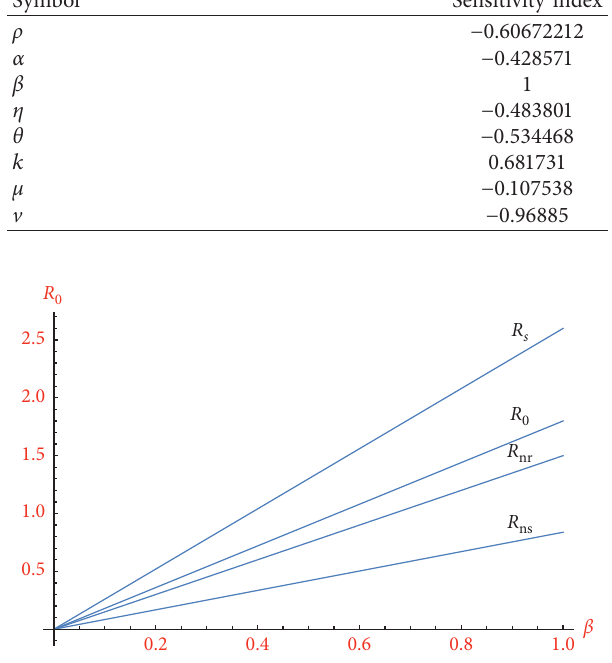
Table 2: Sensitivity indices of model parameters to R